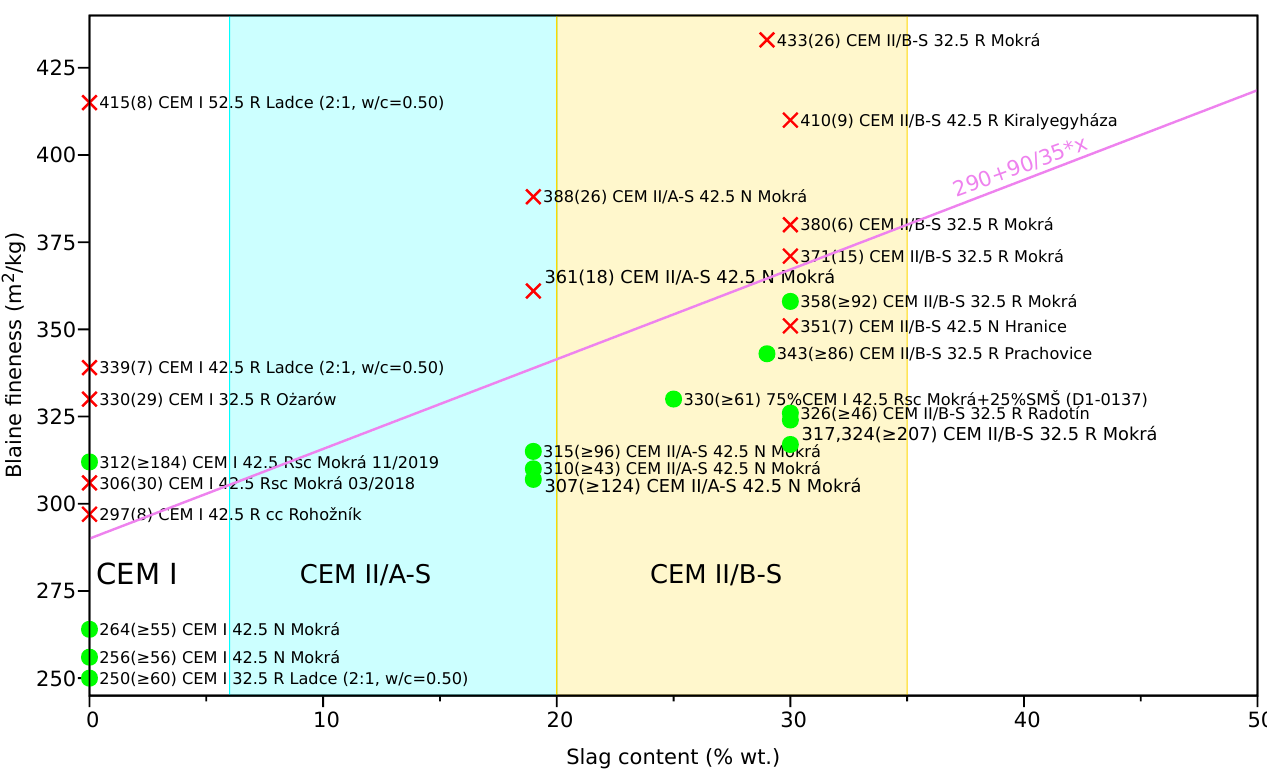
Figure 8. Results from 25 cements measured in the ring test. Each label marks Fine- ness(Average_cracking_time) Cement_description . Green dots mark crack-resistant cements, red crosses mark cements cracking under 40 days in the ring